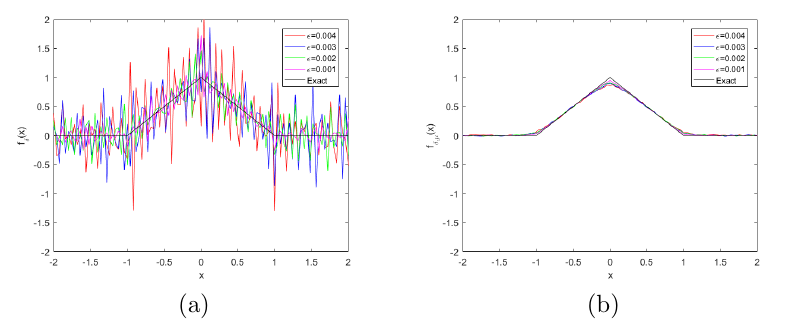
Figure 2. Sources for Example 2: unregularized (a) and regularized (b) assuming α 2 = 2 , β = 0 ,ν = 1 ,t 0 = 0 . 2 ,p = 2 and (cid:15) ∈ { 0 . 004 , 0 . 003 , 0 . 002 , 0 . 001 } .